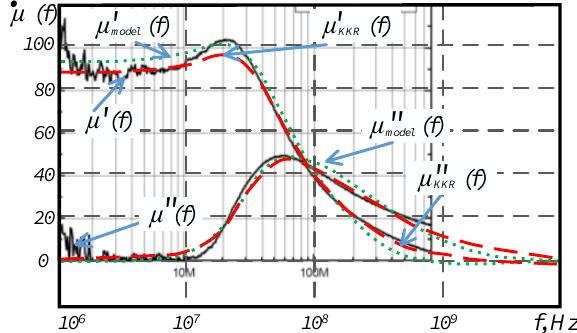
Fig. 9. Analysis of CIP of 3D AB5016RF ferrite